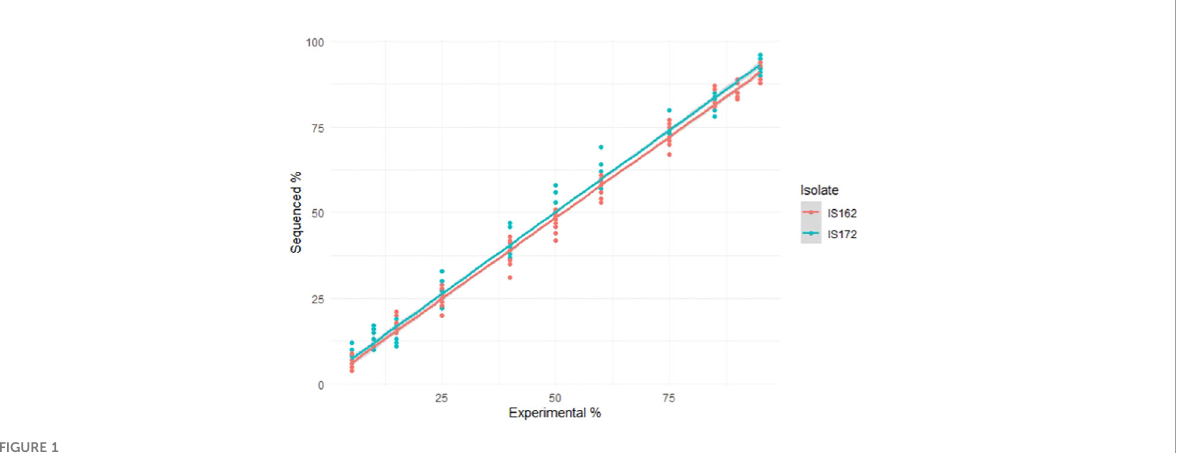
FIGURE 1 Scatter plot and fi tted line representing the sequenced percentage of each isolate or observed percentage in the laboratory and the experimental or expected